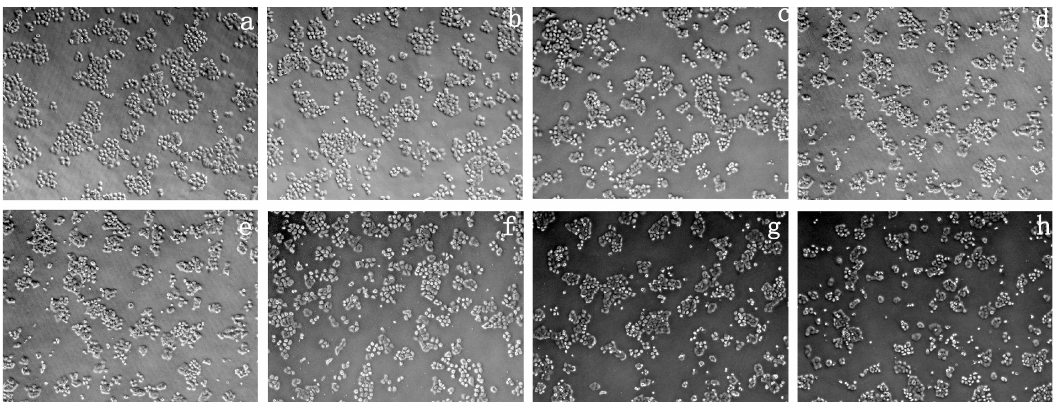
Figure 5. Performance of human hepatic cells (LO2) treated with various concentrations of SY and SY-OMCS: ( a ) control SY; ( b ) 0.25 g/L SY; ( c ) 0.5 g/L SY; ( d ) 1 g/L SY; ( e ) control SY-OMCS; ( f ) 1 g/L SY-OMCS; ( g ) 2 g/L SY-OMCS; ( h ) 4 g/L SY-OMCS.